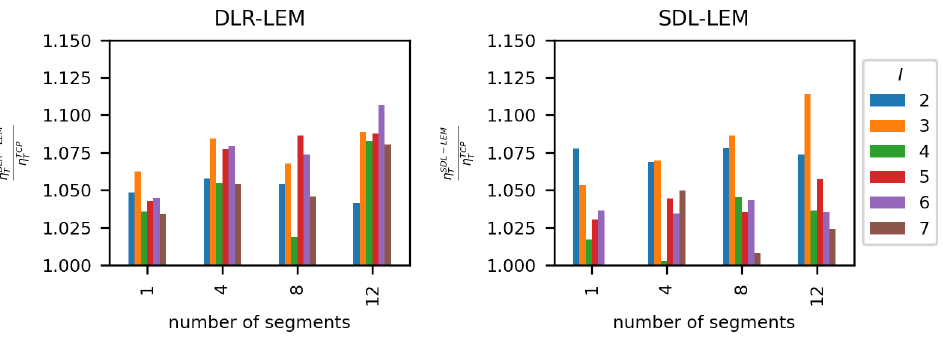
Figure 15. η T Relation between active TCP test approach and proposed methods.